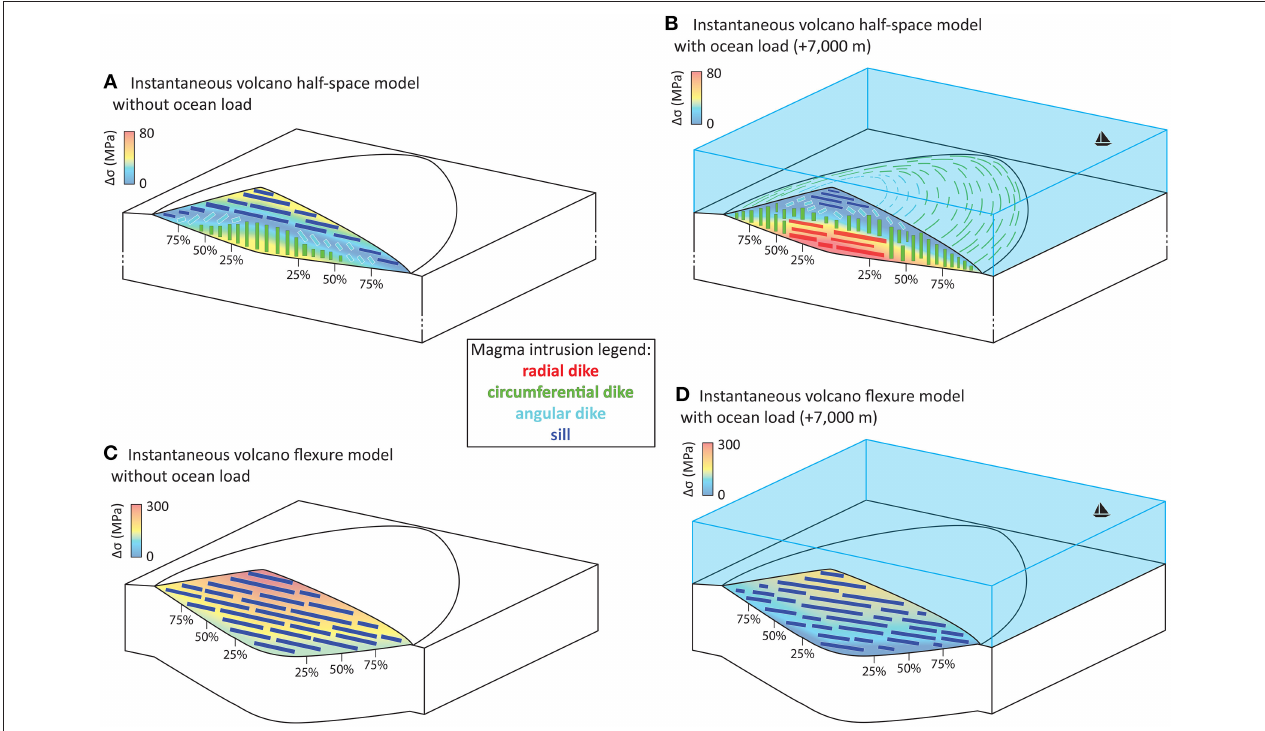
FIGURE 4 | Sketch illustrating the state of stress and the type of magmatic intrusions within instantaneously-formed volcanoes in (A,B) half-space and (C,D) flexure models without an ocean load (A,C) and (B,D) with an ocean load ( + 7,000m). Sill intrusions are presented by dark blue-colored bars, while angular, circumferential and radial dikes presented by light blue, green and red-colored bars (in cross-section) and lines (at the surface of the edifice). Background colors represent the amount of differential stress ( 1 σ ; similar 1 σ scales are applied for A,B ; and for C,D